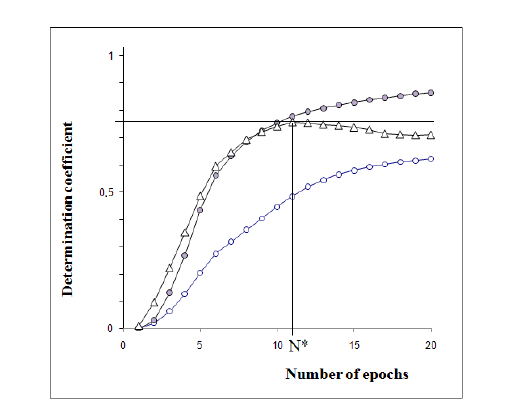
Figure 1. The co-evolution of correlations during 20 epochs of the Monte Carlo method optimization. N* is the value of the epochs which gives the maximumcorrelation coefficient for the external test set.